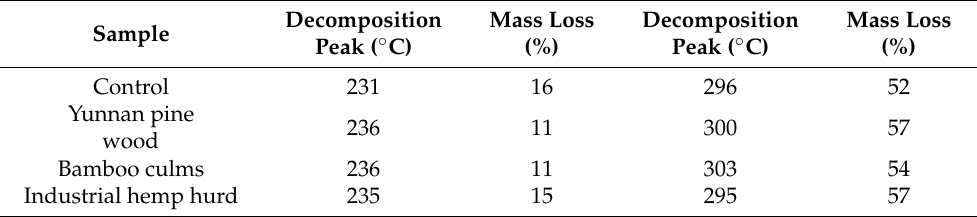
Table 6. Effect of addition of Yunnan pine wood, bamboo culms, and industrial hemp hurd fibers obtained using pectinase + hemicellulase treatment on decomposition peaks and mass losses of CMC